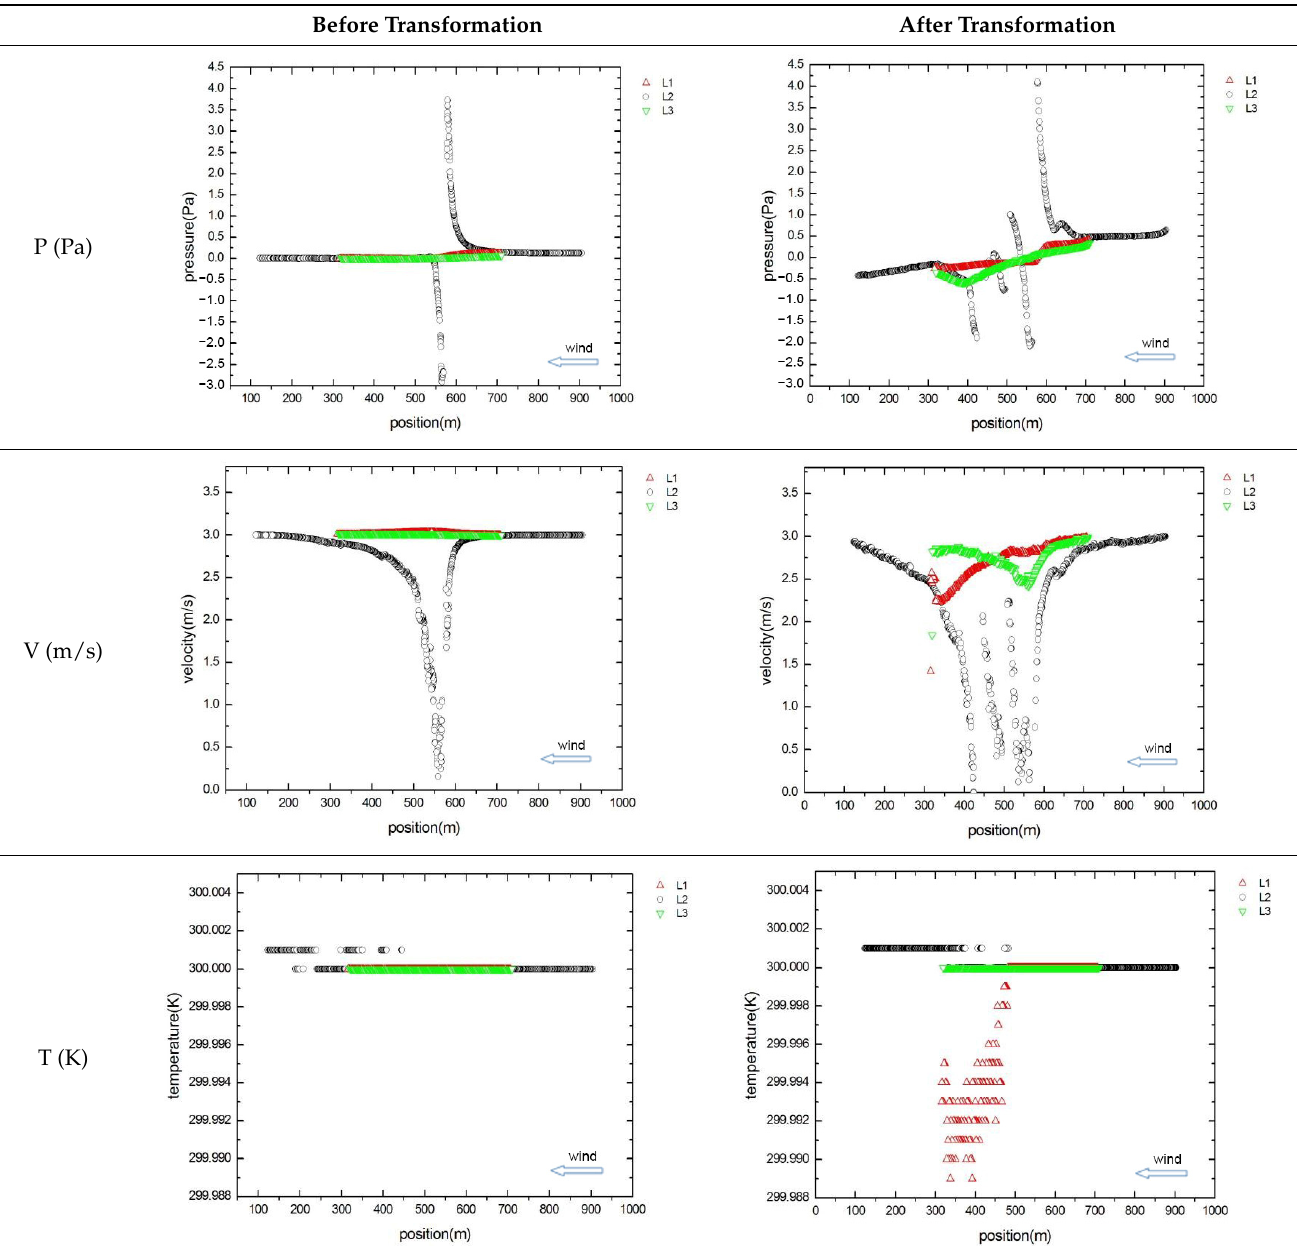
Table 4. Observation points’ pressure, wind speed and temperature comparison before and after the transformation.